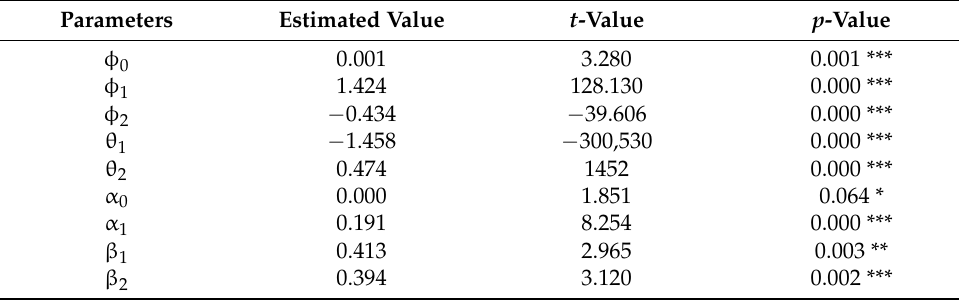
Table 4. ARMA (2,2)-GARCH (1,2) estimated